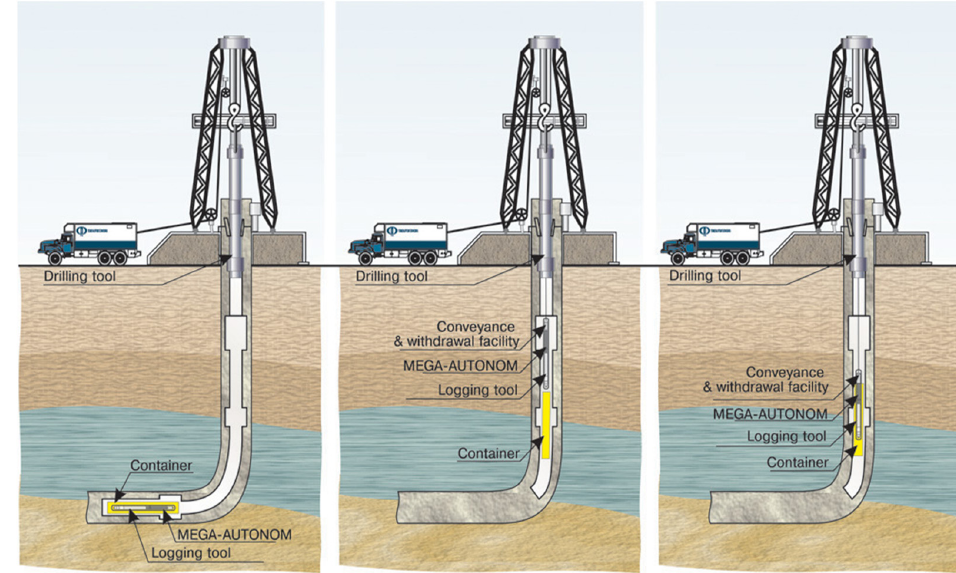
Figure 1. Logging process.